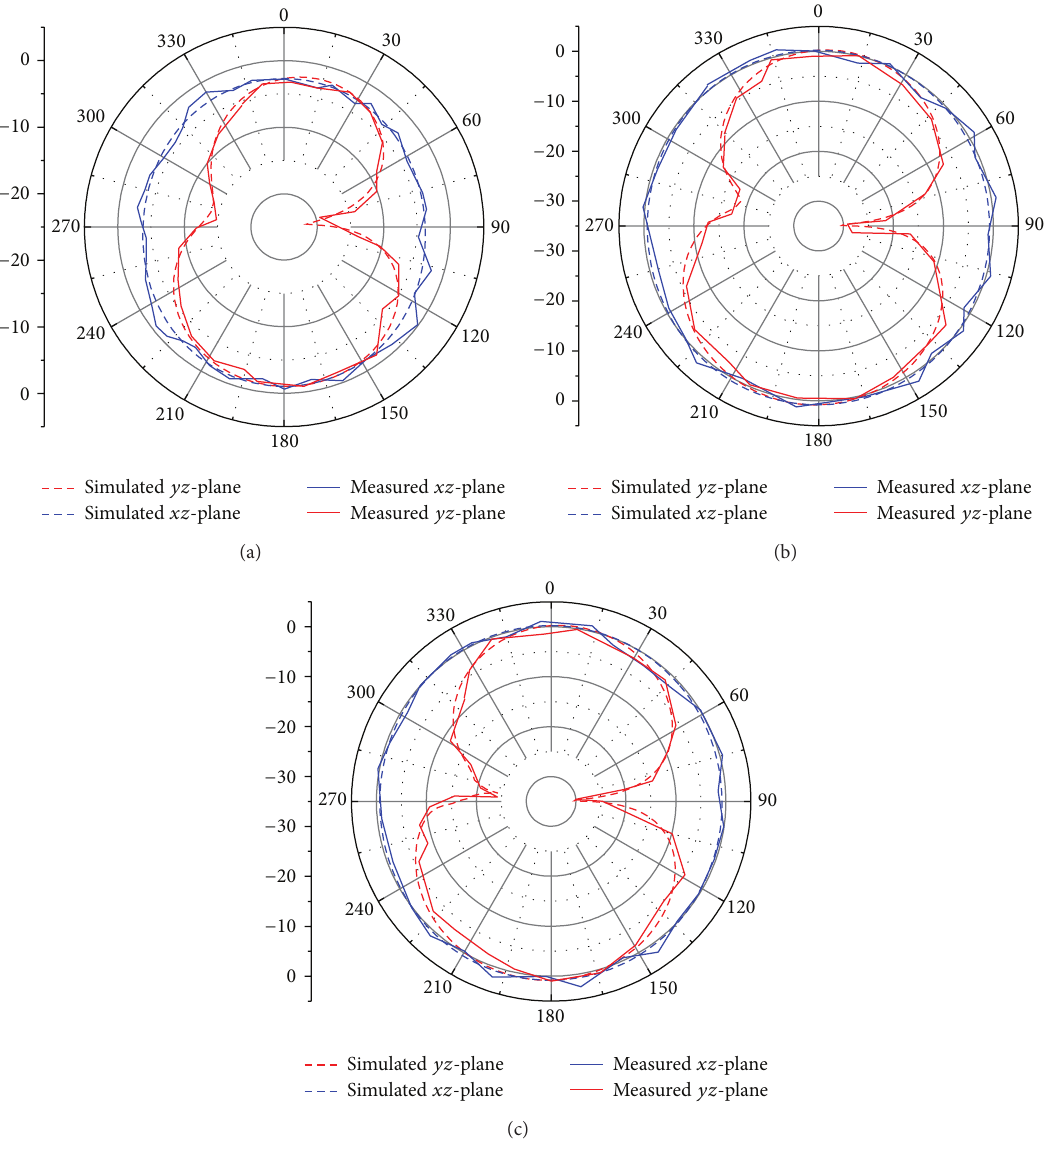
Figure 21: Measured and simulated radiation patterns of the proposed antenna: (a) 3.2 GHz, (b) 5 GHz, and (c)